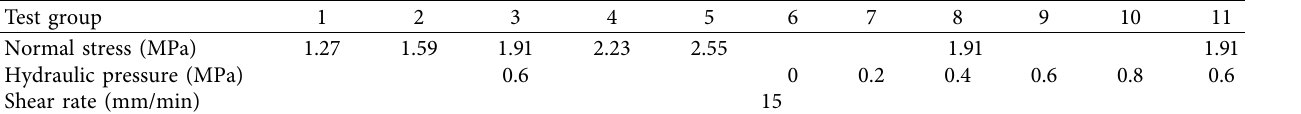
Table 2: Test conditions description.